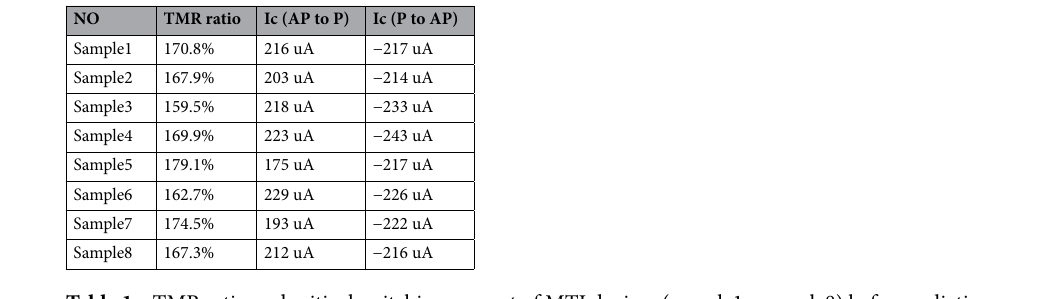
Table 1. TMR ratio and critical switching current of MTJ devices (sample1 ~ sample8) before radiation.